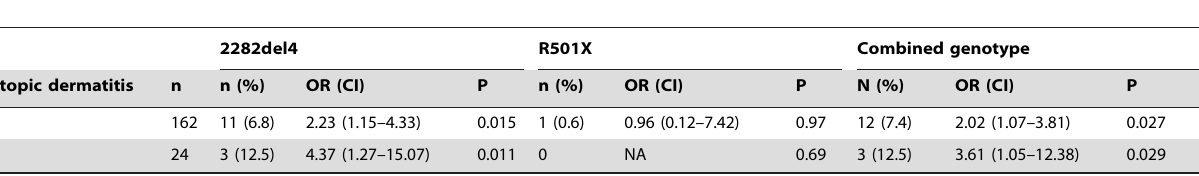
All comparisons vs. healthy controls (Table 1), NA: not available. doi:10.1371/journal.pone.0016933.t003 PLoS ONE |